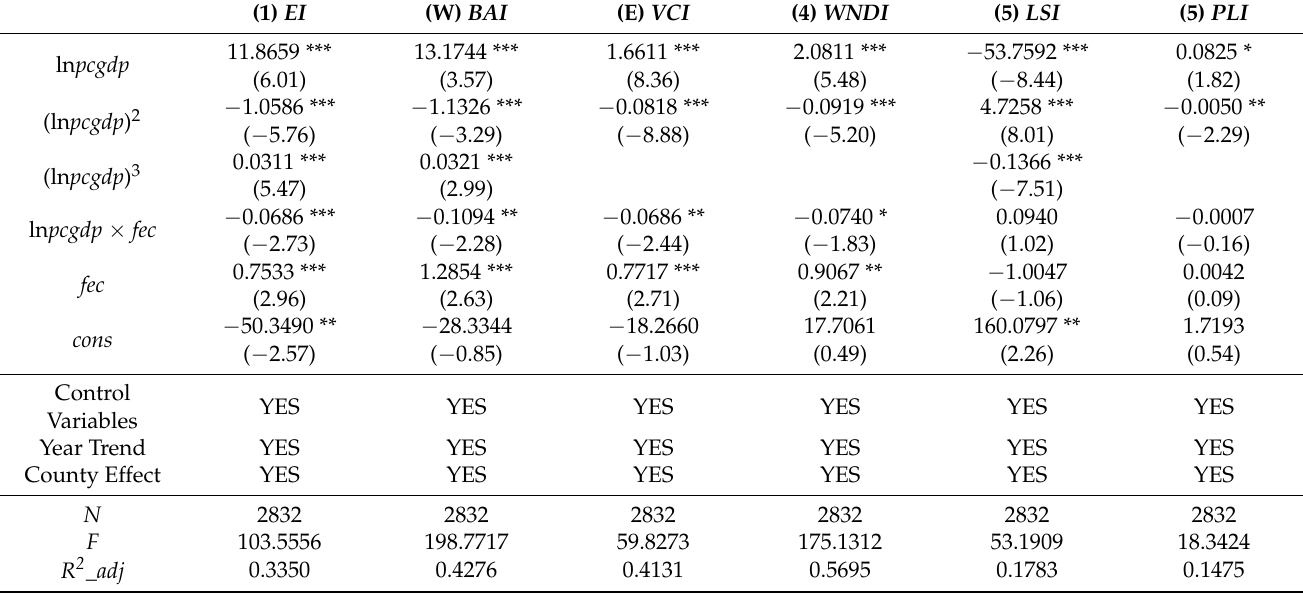
Table 5. The regression results of the impact of fiscal ecological